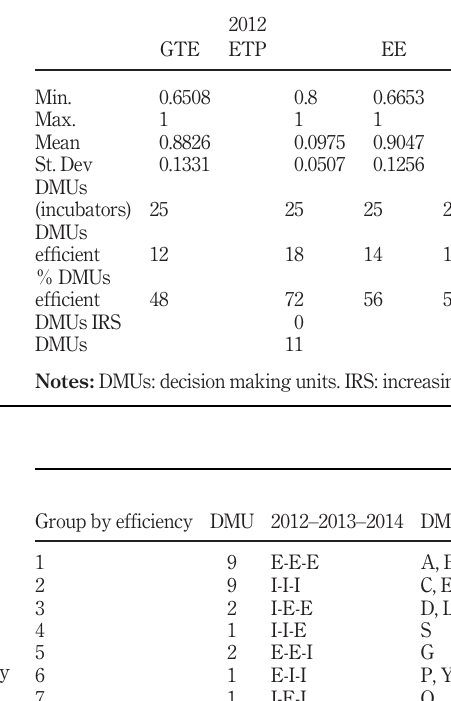
Table 5. Incubator groups by ef fi ciency